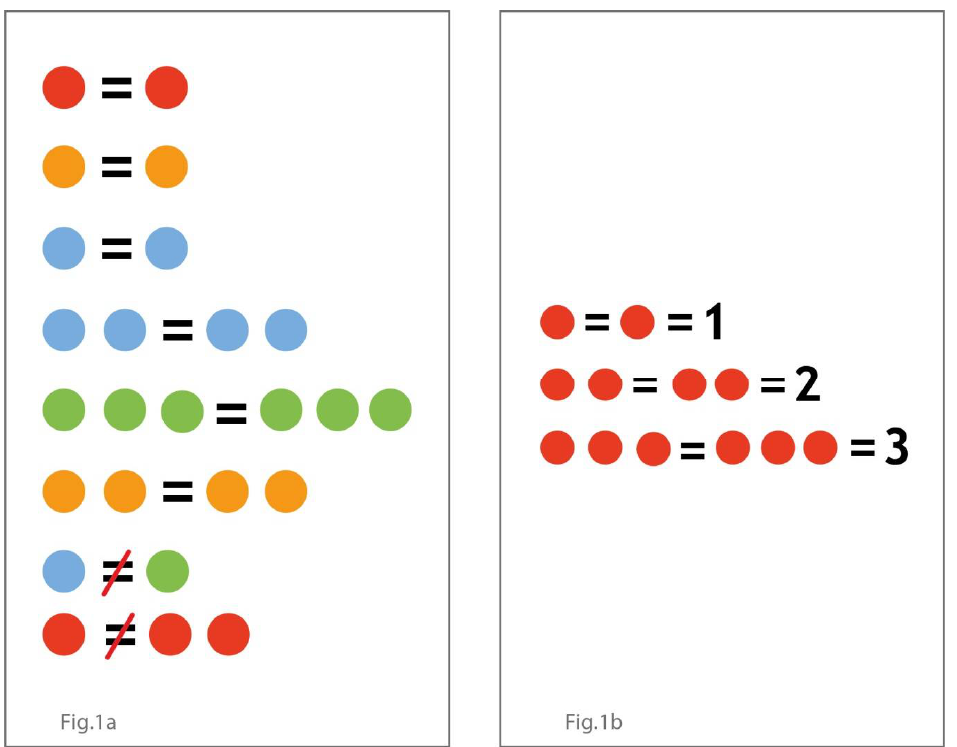
Figure 1. Creating the visual code. ( 1a ) Equal and different; ( 1b ) Numbers.